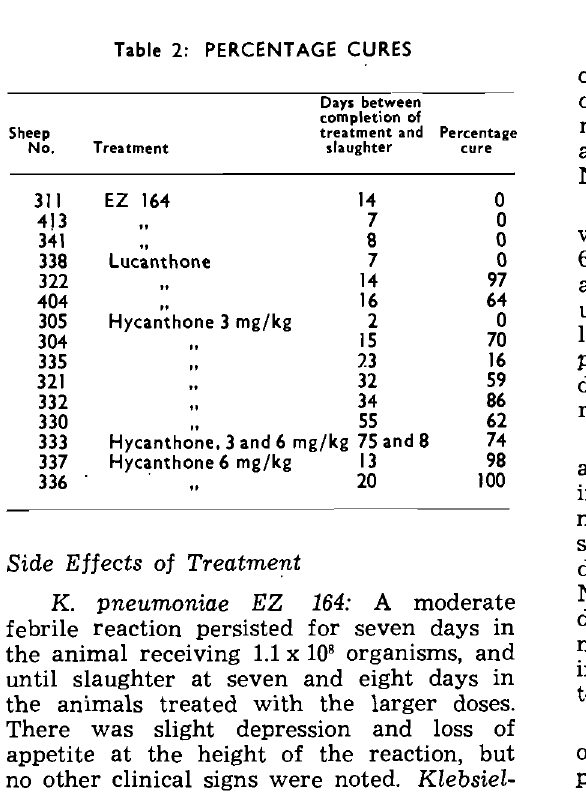
Days between completion of